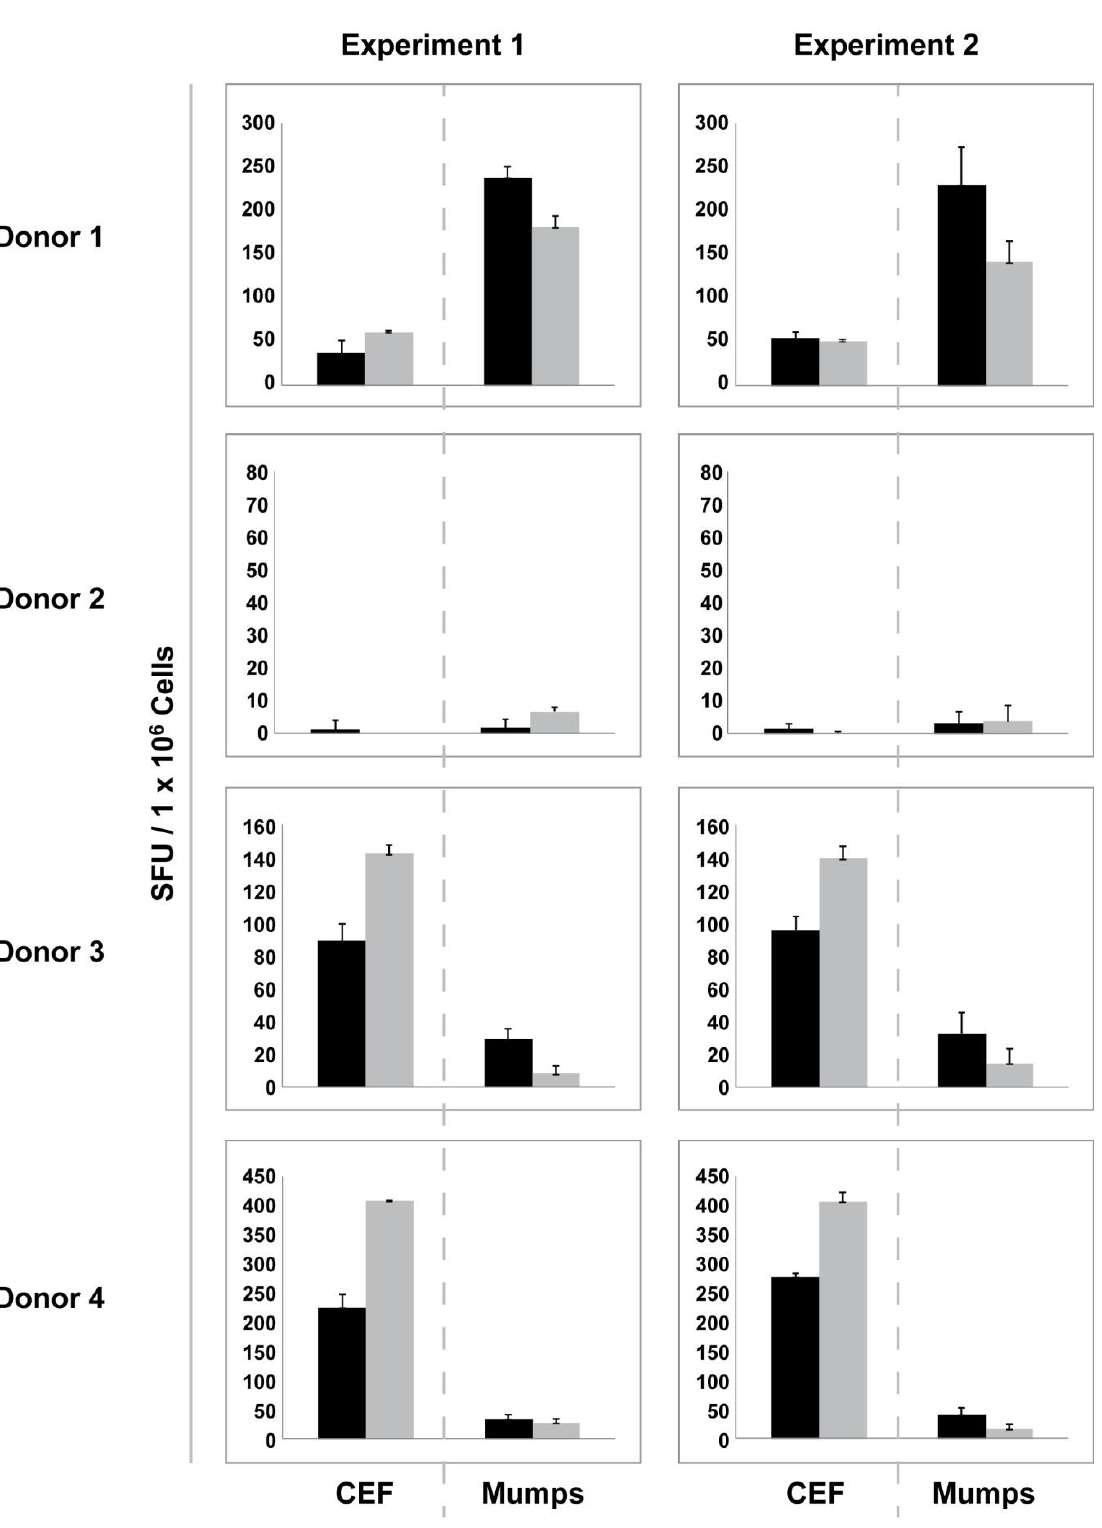
Figure 4. Gain or loss of function after resting is an inherent feature of PBMC samples. Responses to CEF peptide pool and mumps antigen were assessed with and without resting in two independent experiments for each donor. Data are shown for four donors who are fully representative of all the 25 donors tested. Black bars represent responses from freshly thawed cells while grey bars represent responses elicited by rested PBMC. Error bars depict the SD of the SFU from triplicate